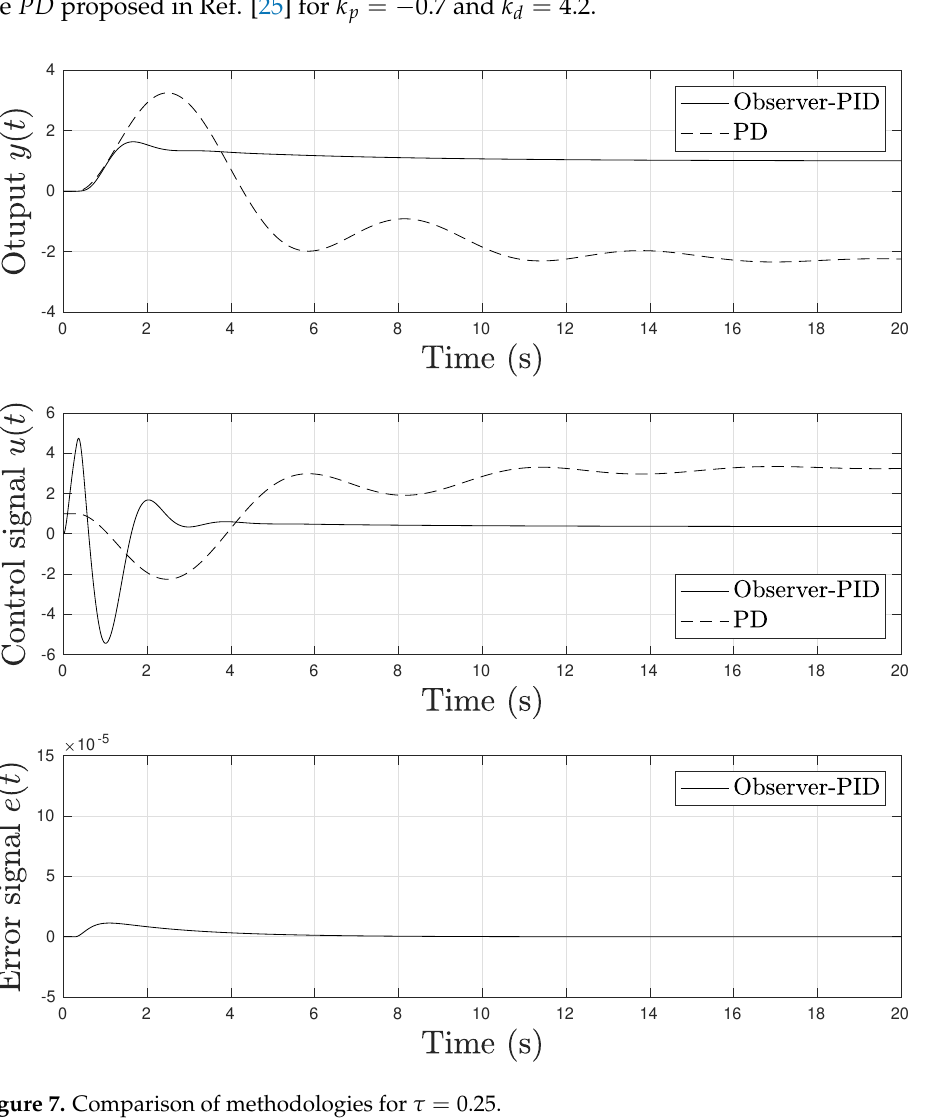
Figure 7. Comparison of methodologies for τ =